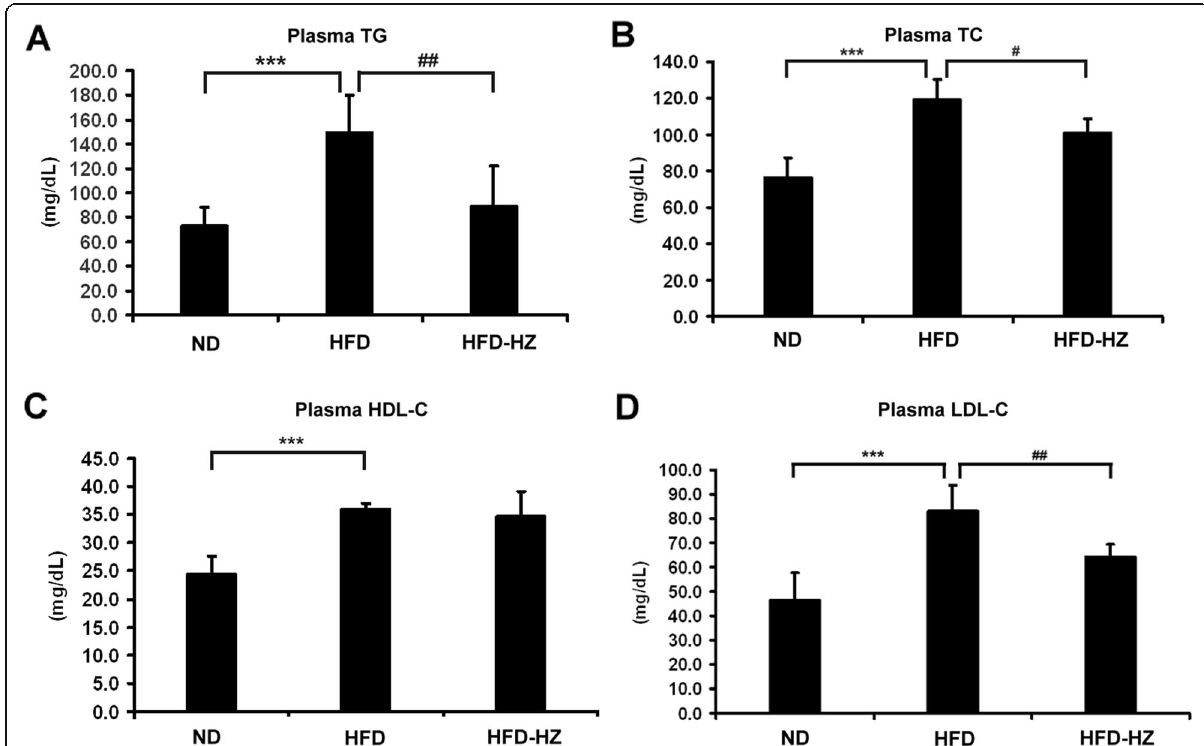
Fig. 5 The effect of HZ extract treatment on plasma lipid levels in C57BL/6J mice fed an HFD. The levels of plasma TG ( a ), TC ( b ), HDL-C ( c ), and LDL- C ( d ). Data are shown as means ± SEM (n=10 per group). ND vs. HFD: * p <0.05; ** p <0.01; *** p <0.001. HFD vs. HZ: # p <0.05; ## p <0.01; ### p <0.001